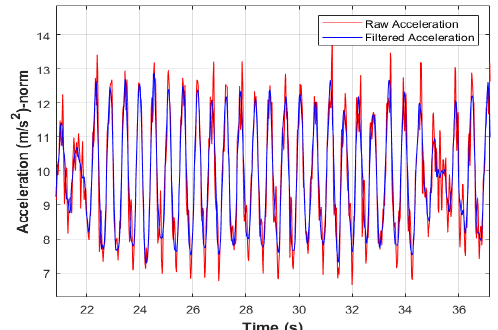
Figure 3: Raw and filtered acceleration data